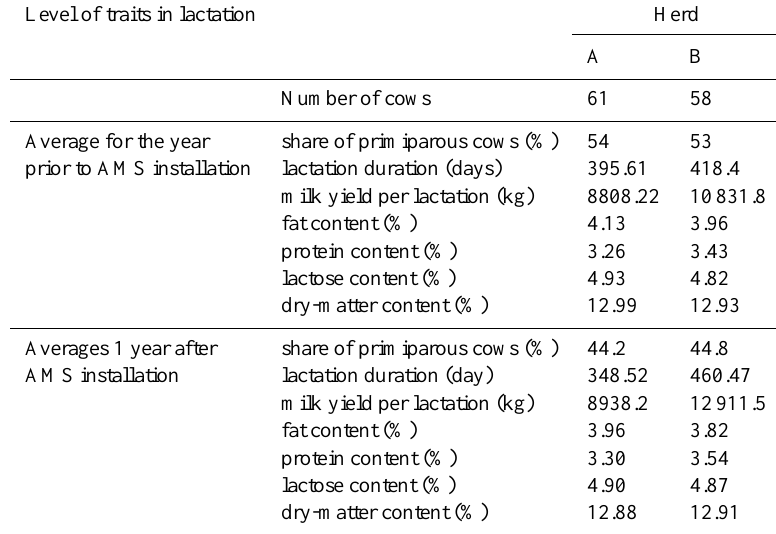
Table 1. The level of traits related to cow milk yield in farms equipped with an AMS. Level of traits in